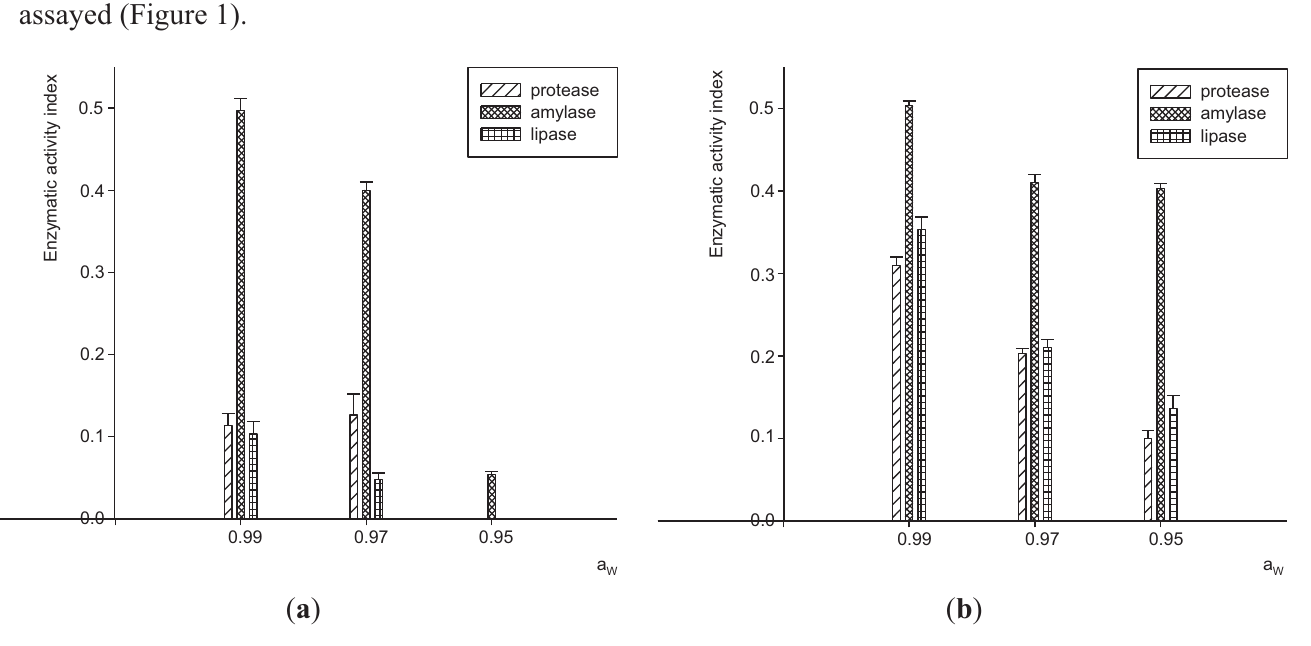
Figure 1. Extracellular enzyme activity index of two strains of P. lilacinum ( a ) JQ926212 and ( b ) JQ926223. Tuckey test ( P < 0.05) was used to compare different enzymatic activity for the same